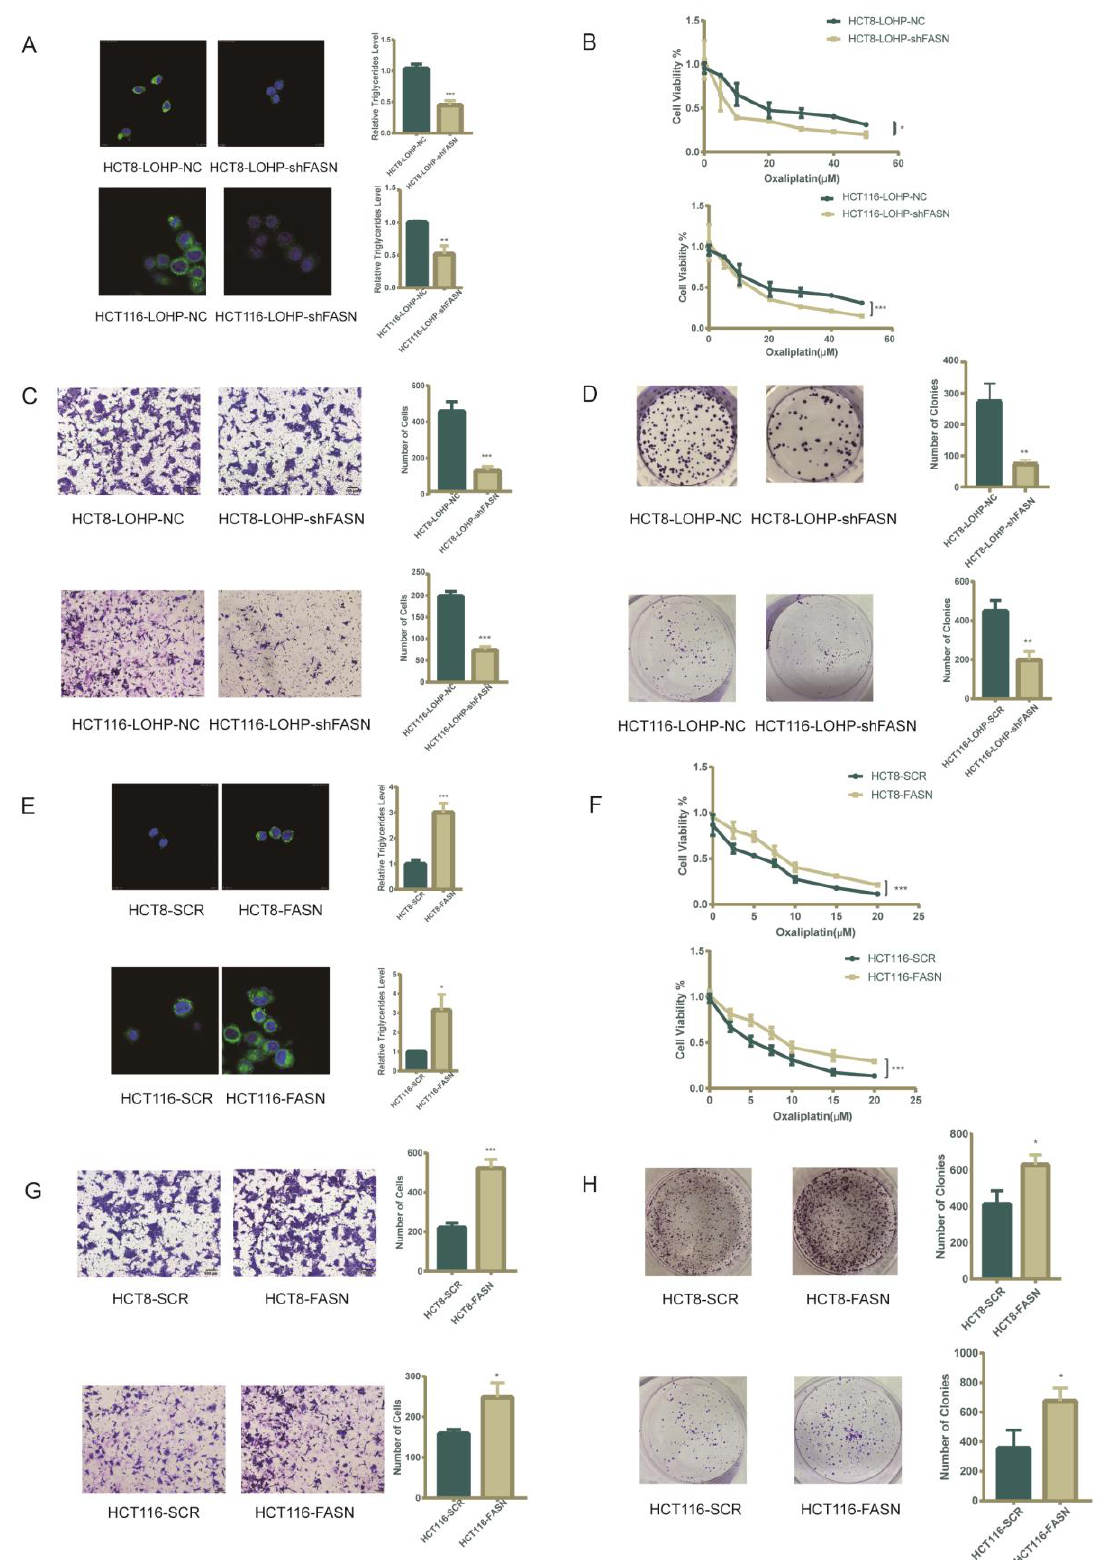
Figure 2. De novo lipid biosynthesis makes CRC cell lines more resistant to oxaliplatin. ( A ) Intracellular neutral lipid droplets and triglycerides were decreased in oxaliplatin-resistant cells after FASN knockdown. The storage of lipids is shown as bodipy 493/503 staining of neutral lipid droplets. ( B ) Upon treatment with same dose of oxaliplatin, there was a significant fold decrease in proliferation in the FASN knockdown CRC cells. ( C ) Transwell assay indicated that FASN knockdown inhibited